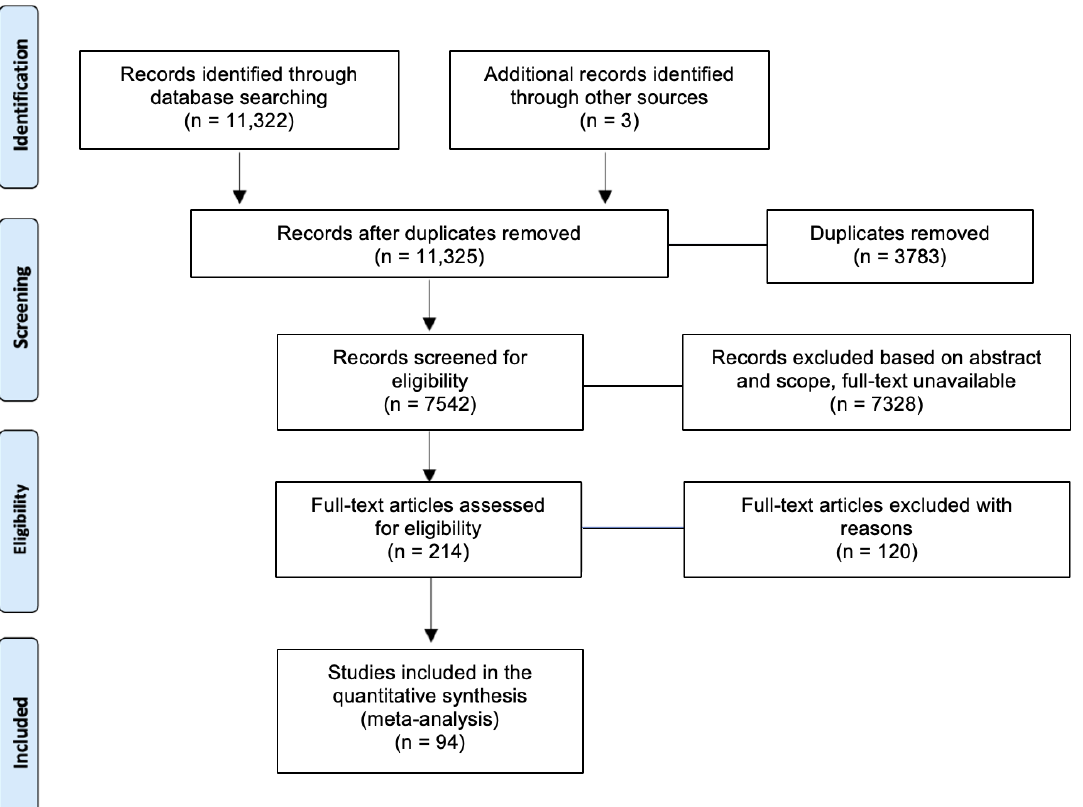
Figure 1. PRISMA flow diagram of article selection.